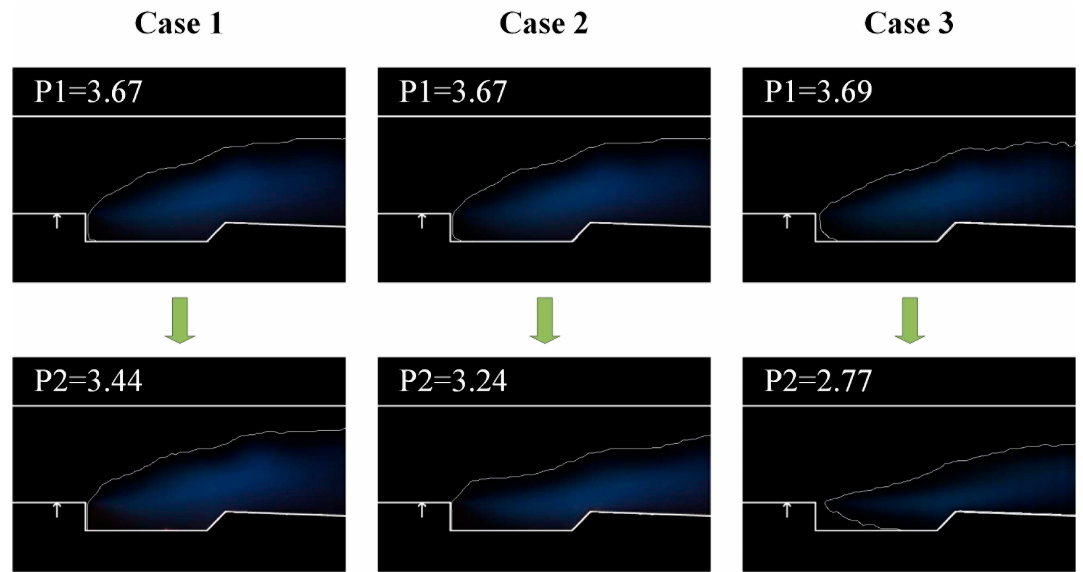
Figure 3. Comparison of the time-averaged flame during stable combustion before and after the condition transition (Upper images: condition 1; Lower images: condition 2).